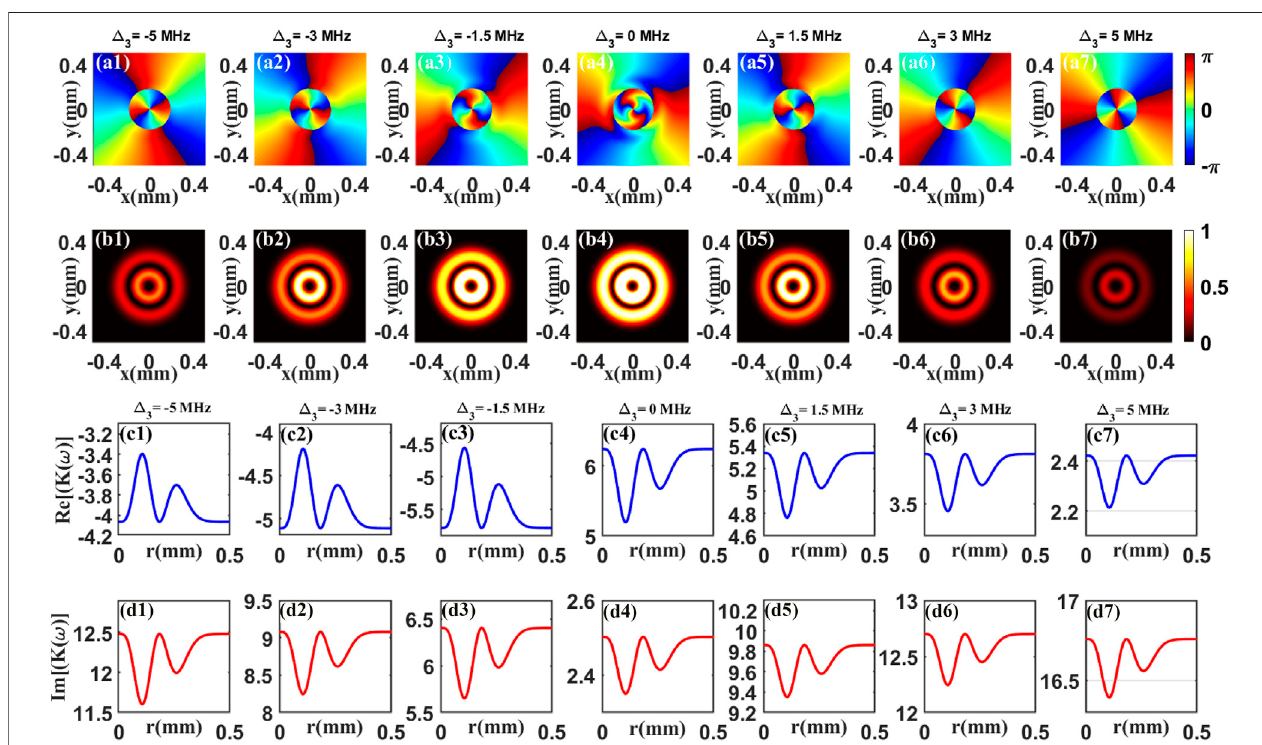
FIGURE3| Phase (A1 – A7) and normalized intensity (B1 – B7) patterns oftheFWM fi eldfordifferentdetuning Δ 3 .Thereal (C1 – C7) andimaginary (D1 – D7) partsof dispersion relation K ( ω ) versus radius r for different detuning Δ 3 . The other parameters are the same as in Figure 2 .